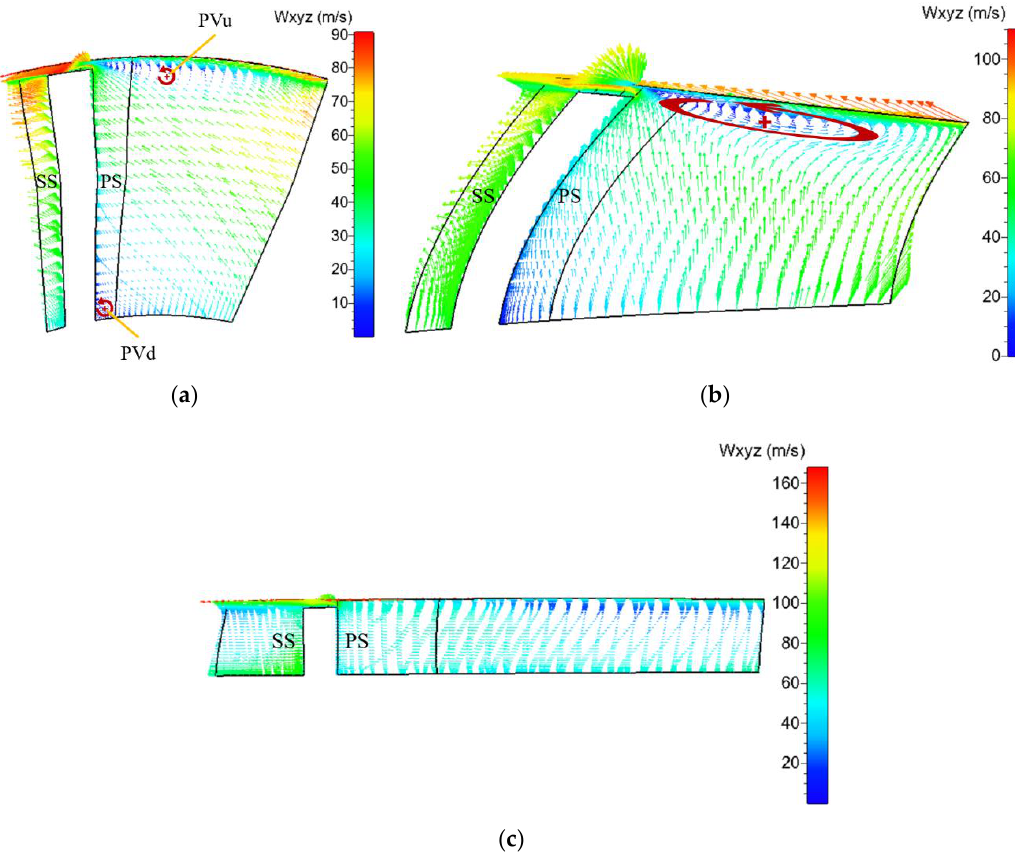
Figure 14. Second flow velocity on S3 sections of the optimal compressor impeller: ( a ) 30% axial chord length; ( b ) 40% axial chord length and ( c ) 90% axial chord